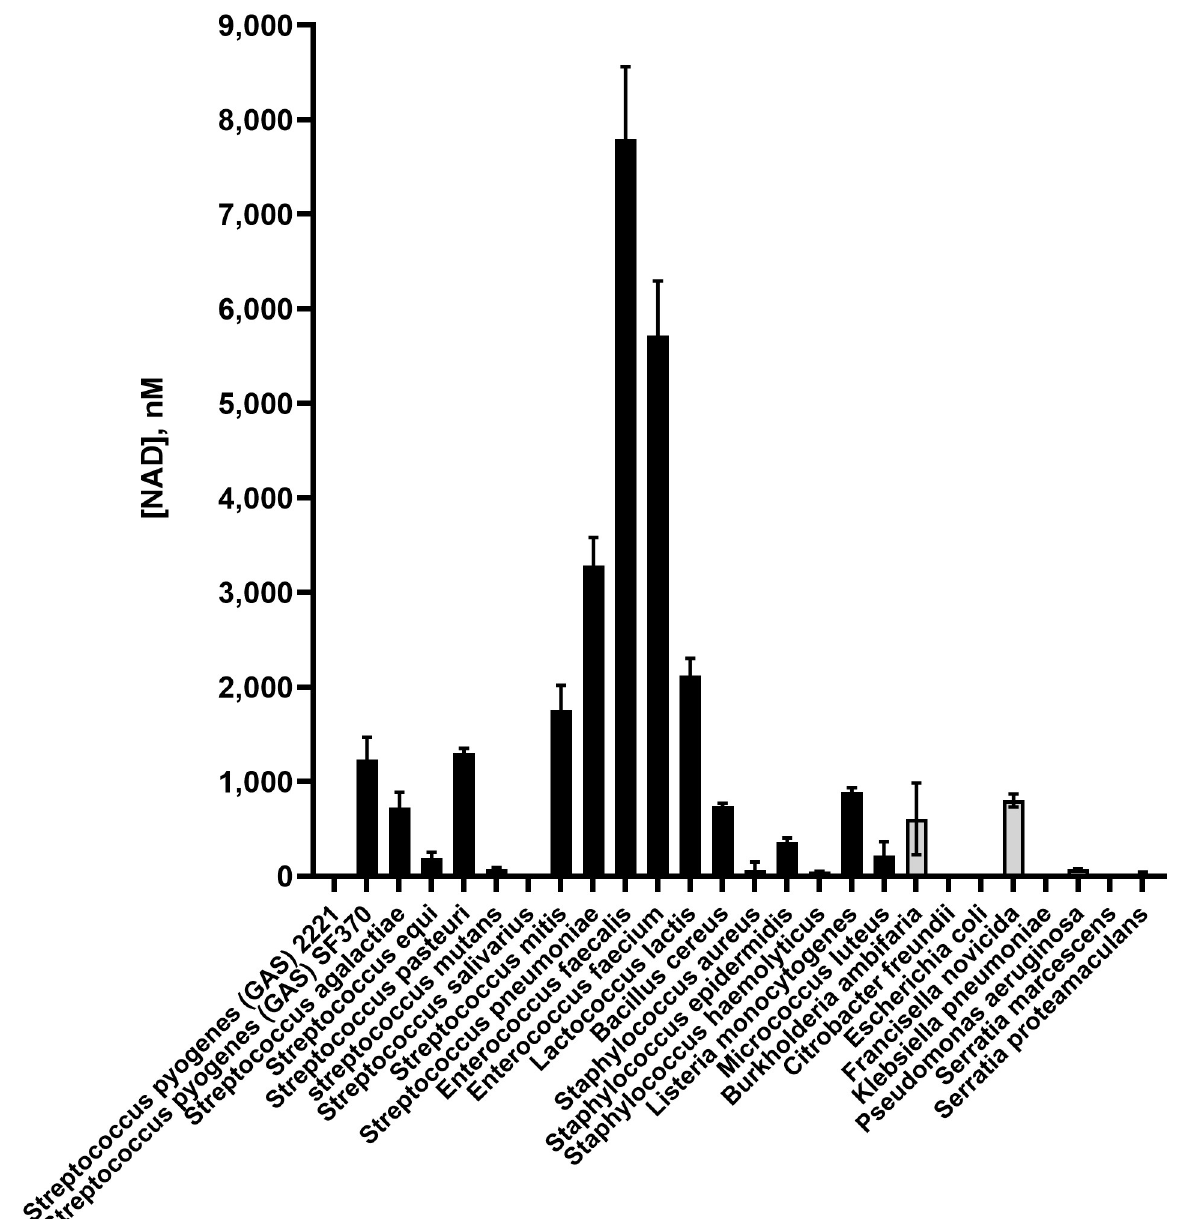
Fig 1. NAD + is released into the growth medium by a variety of bacterial species. NAD + concentration was measured in culture supernatants following bacterial growth for 16 hr. Gram-positive species are indicated by black bars and Gram-negative species by grey bars. Data are the mean of three biological replicates ± standard